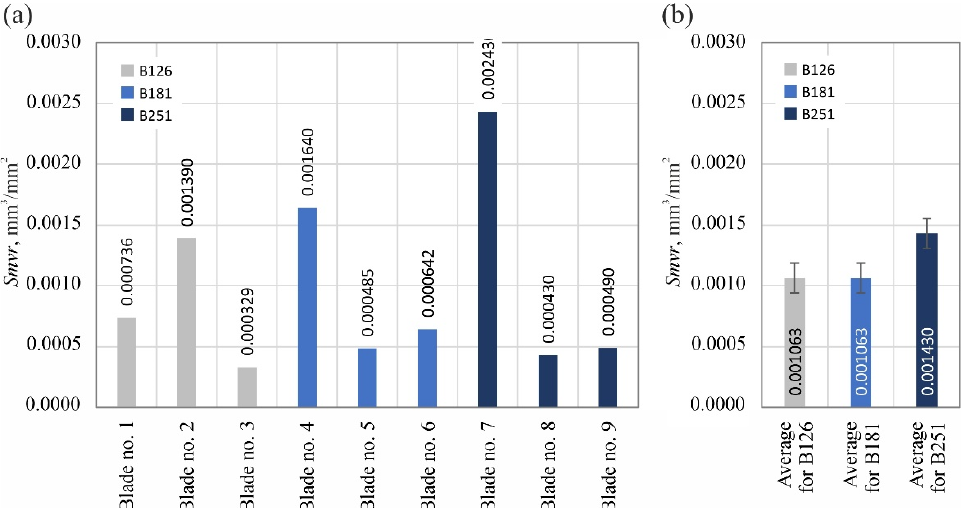
Figure 12. Changes in the total height of the surface St : ( a ) results for nine blades selected for surface texture measurements; ( b ) average values determined by the size of the cBN abrasive grain of the grinding wheel used (error bars represent the standard error equal to the standard deviation σ di- vided by the square root of the total number of samples).